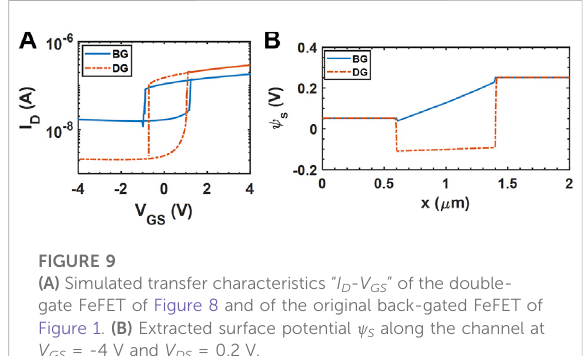
FIGURE 9 (A) Simulated transfer characteristics “ I D - V GS ” of the double- gate FeFET of Figure 8 and of the original back-gated FeFET of Figure 1. (B) Extracted surface potential ψ S along the channel at V GS = -4 V and V DS = 0.2